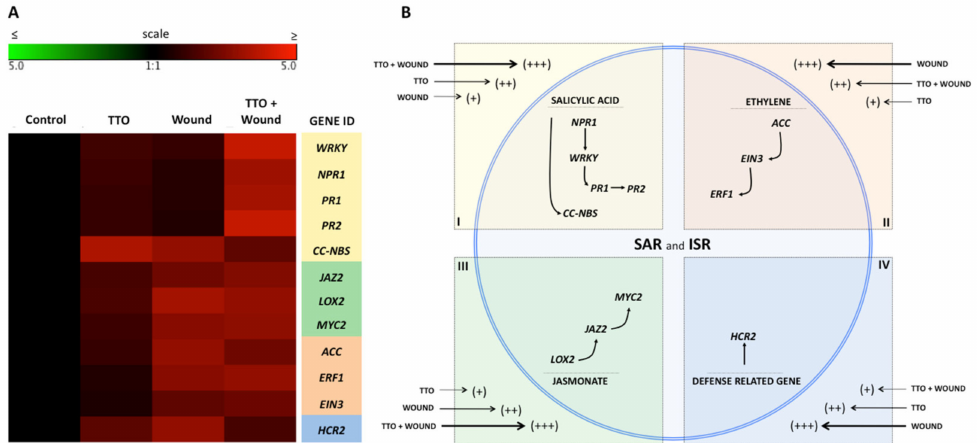
Figure 7. TTO induces systemic resistance in wounded tomato plants. ( A )—The heat map illustrates the doubled changes in gene expression (log2 scale) in samples collected 10 days after application of TTO (TTO); 10 days post wounded (Wound); and 10 days after application of TTO more wounded (TTO + Wound). Di ff erent shades represent induced or repressed gene expression. Biological and technical triplicates were used in the analysis. Gene acronyms are listed in the right column. The defense routes are indicated by colors according to the legend. ( B )—Scheme illustrating regulation of salicylic acid, ethylene and jasmonate pathways in the plant cell. Arrow sizes and scores ( +++ ; ++ ; + ) indicate the intensity of expression of genes related to SAR and ISR